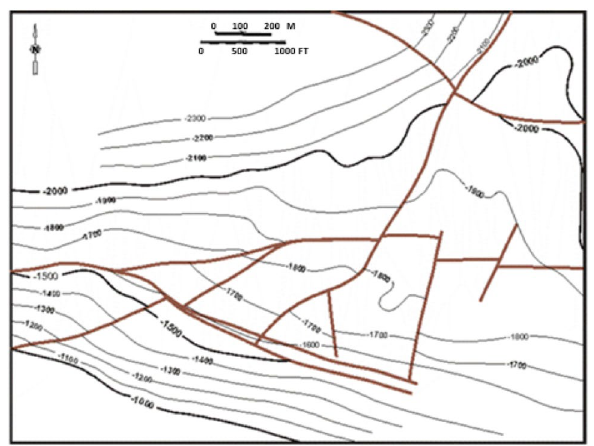
Fig. 5 Structure map of top Cruse (adapted from SPE 89411—Ram- lal